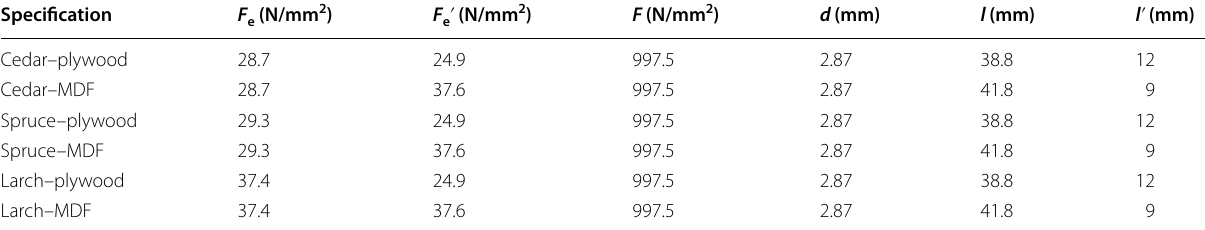
F e and F e ʹ : embedment strength of main member and board material, F : strength of nail; d : diameter on nail, l and l ʹ : inserted length of nail in the main member and thickness of the board material, respectively